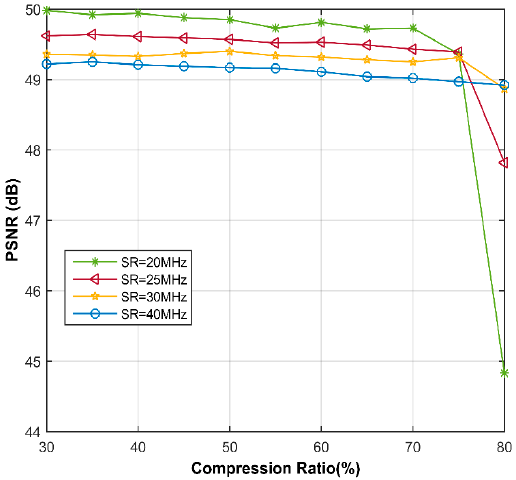
Figure 7. Comparative PSNR between different SRs in frequency domain, using simulated data.